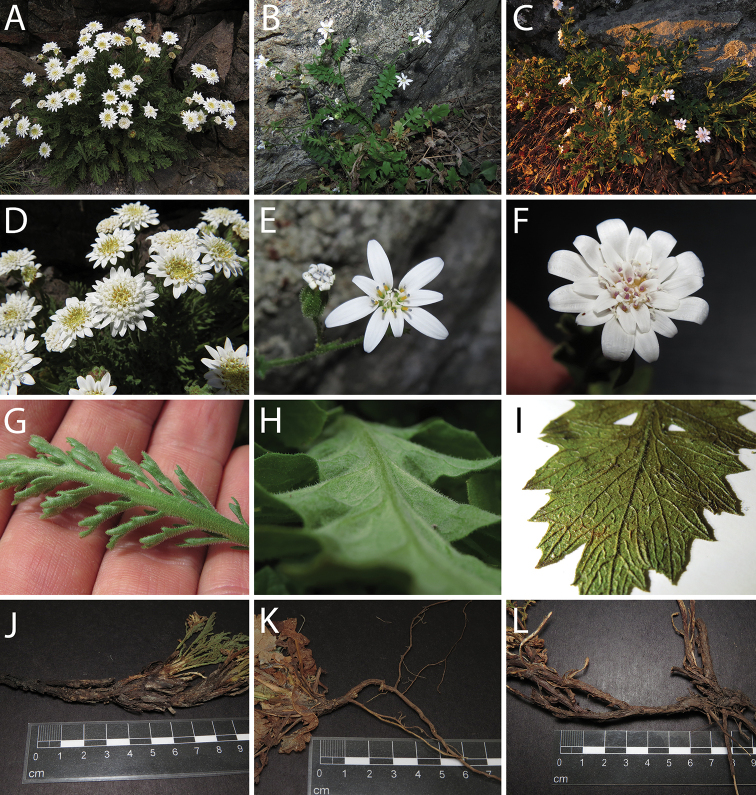
Leucheria
salina (A, D, G, J) (Valle Nevado, Región Metropolitana, Chile), Lecheria
runcinata (B, E, H, K) (Reserva Natural Altos de Cantillana, Región Metropolitana, Chile), and Leucheria
cantillanensis (C, F, I, L) (Reserva Natural Altos de Cantillana, Región Metropolitana, Chile) A–C habit D–F capitula G–I abaxial side of leaves J–L belowground structures. All Photographs by Lavandero.